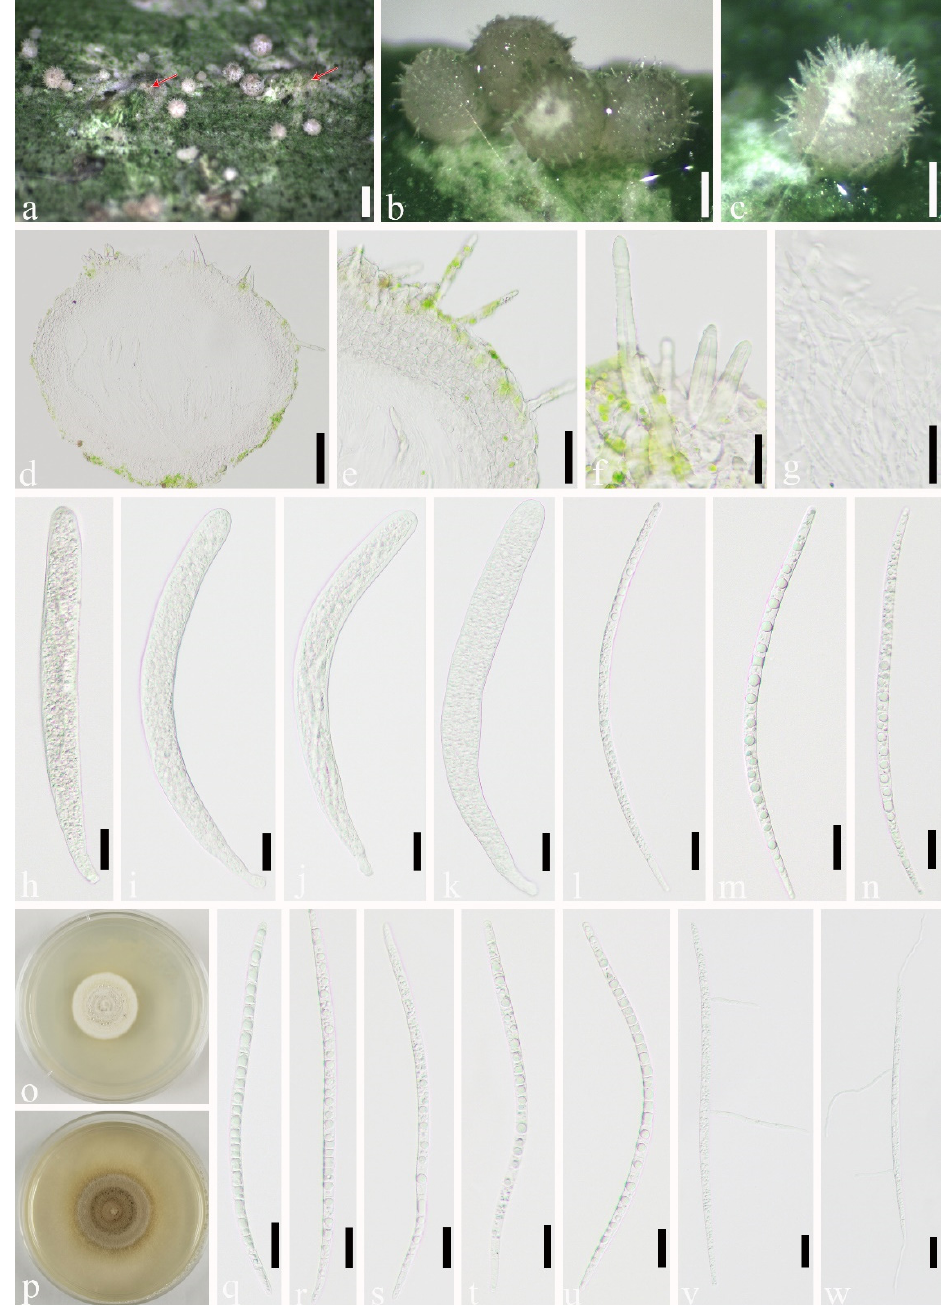
Figure 5. Podonectria kuwanaspidis (SICAU 21-0002, holotype). ( a ) Ascomata on or around the scale-host (red arrow). ( b ) Aggregated ascomata. ( c ) Solitary ascomata. ( d ) Section through ascoma. ( e ) Peridium. ( f ) Hairs covering ascoma. ( g ) Pseudoparaphyses. (h–k) Asci. ( l – n , q – u ) Ascospores. ( o , p ) Colonies on PDA after 25 days and 50 days. ( v , w ) Germinated ascospores. Scale bars: ( a ) 500 μ m,